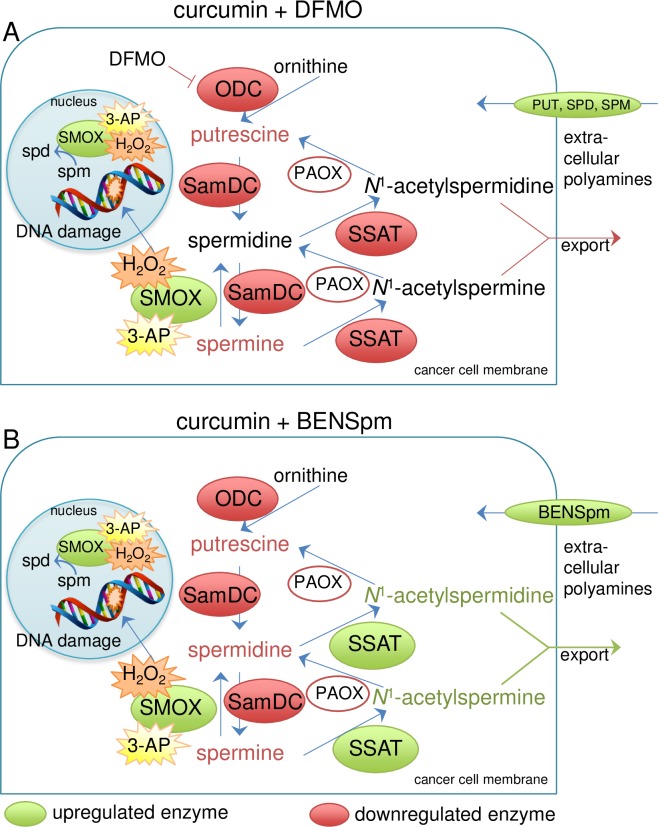
Proposed mechanisms of the combinatorial effects of curcumin with DFMO or BENSpm.Treatment with curcumin alone down regulates the biosynthetic enzymes ODC and SamDC, while up regulating SMOX. The result is decreased putrescine and the conversion of spermine back to spermidine. SSAT activity is lowered, likely due to the decrease in spermine. (A) Adding DFMO further inhibits ODC, reducing the spermidine generated through biosynthesis. Compensatory uptake of polyamines from the extracellular environment would likely be increased by both DFMO and curcumin. (B) Uptake of BENSpm through the polyamine transporter is stimulated by the curcumin-mediated decrease in biosynthesis. BENSpm induces catabolism through SSAT, thereby increasing the depletion of spermine and catabolizing the spermidine accumulated by the induction of SMOX by curcumin. As no accumulation of putrescine is evident, the acetylated polyamines are presumably exported from the cell.